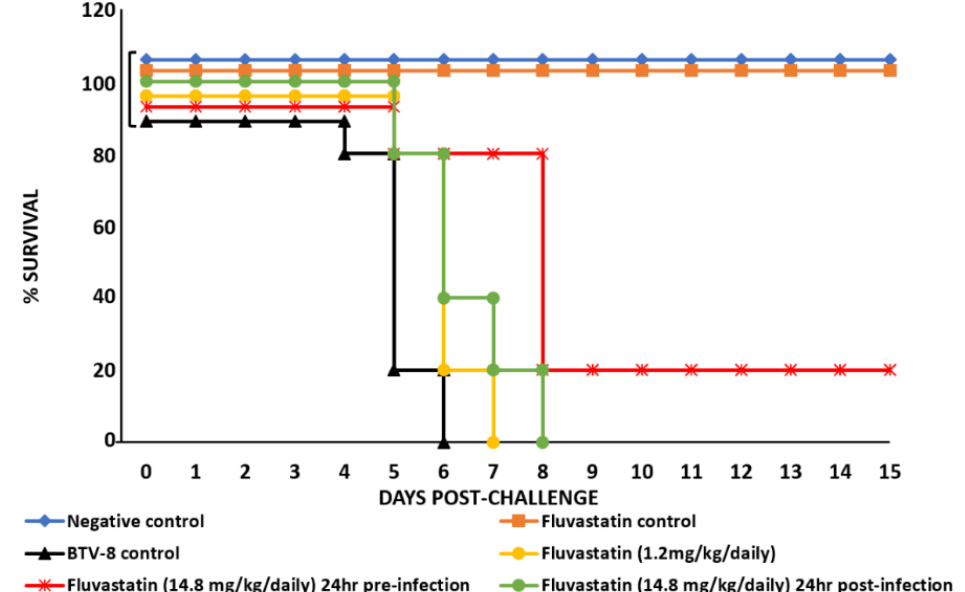
Figure 8. Survival curves of IFNAR (−/−) mice.